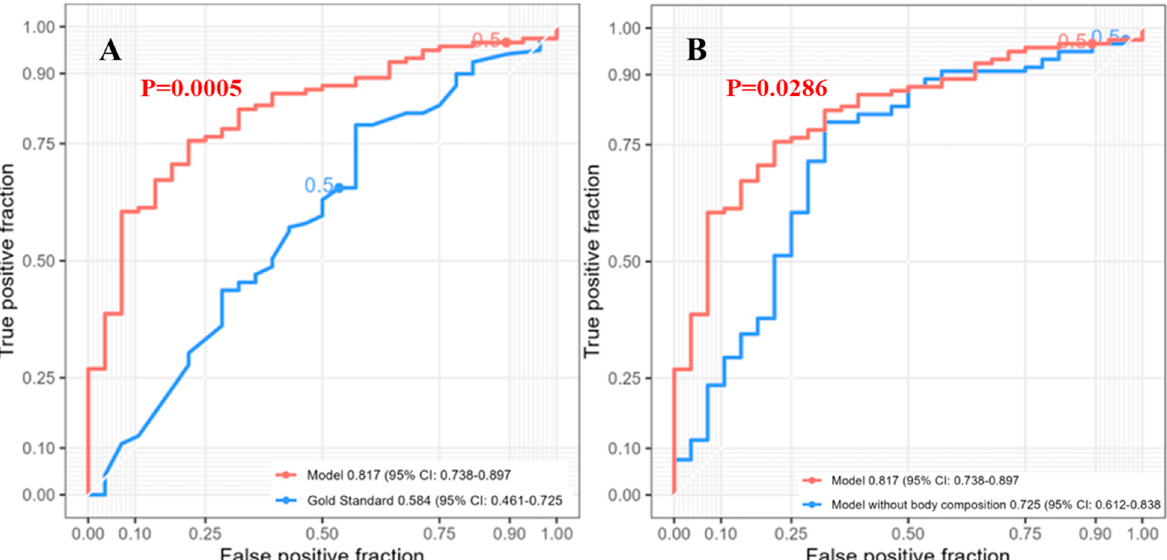
Figure 1. ROC curves of SVM models predicting one-year post-esophagectomy survival (n = 147). ( A ) Full SVM model and reference model. ( B ) SVM models with and without body composition variables. SVM = support vector machine. ROC = receiver operating characteristic.